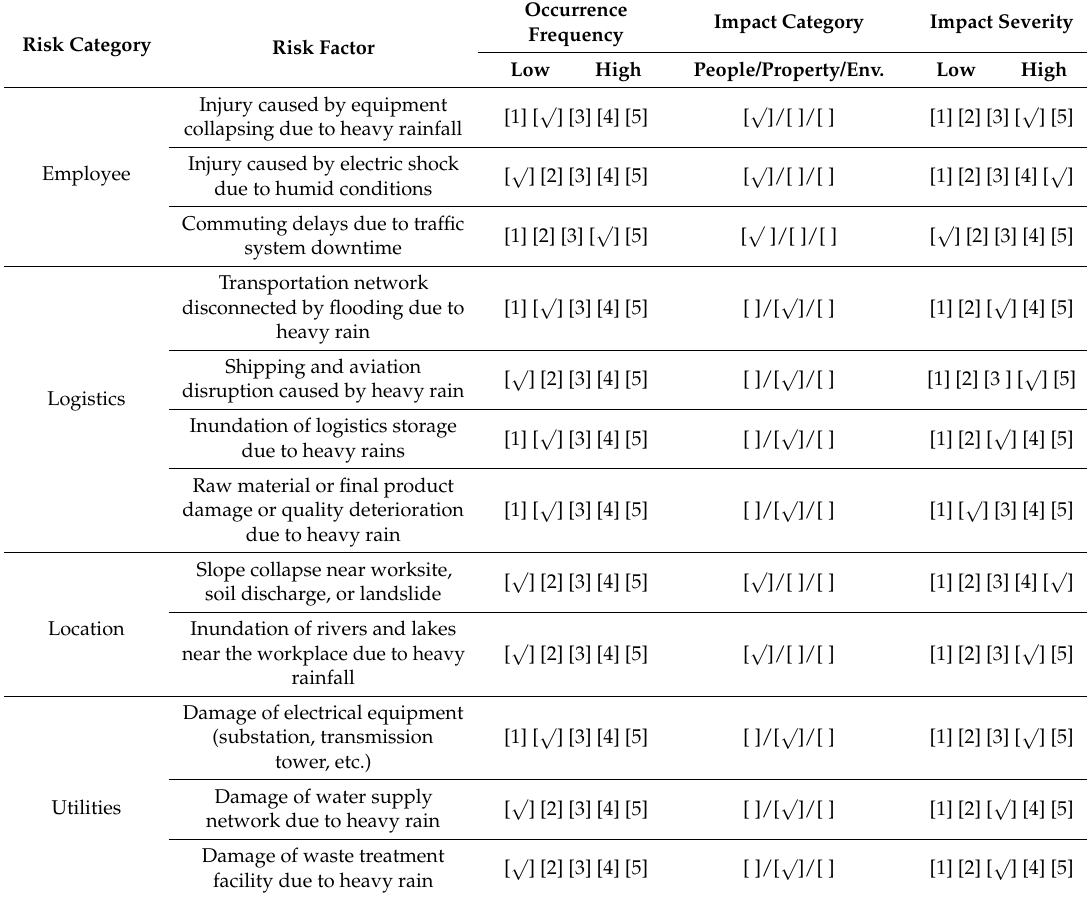
Table 2. The sample checklist for identify risks caused by heavy